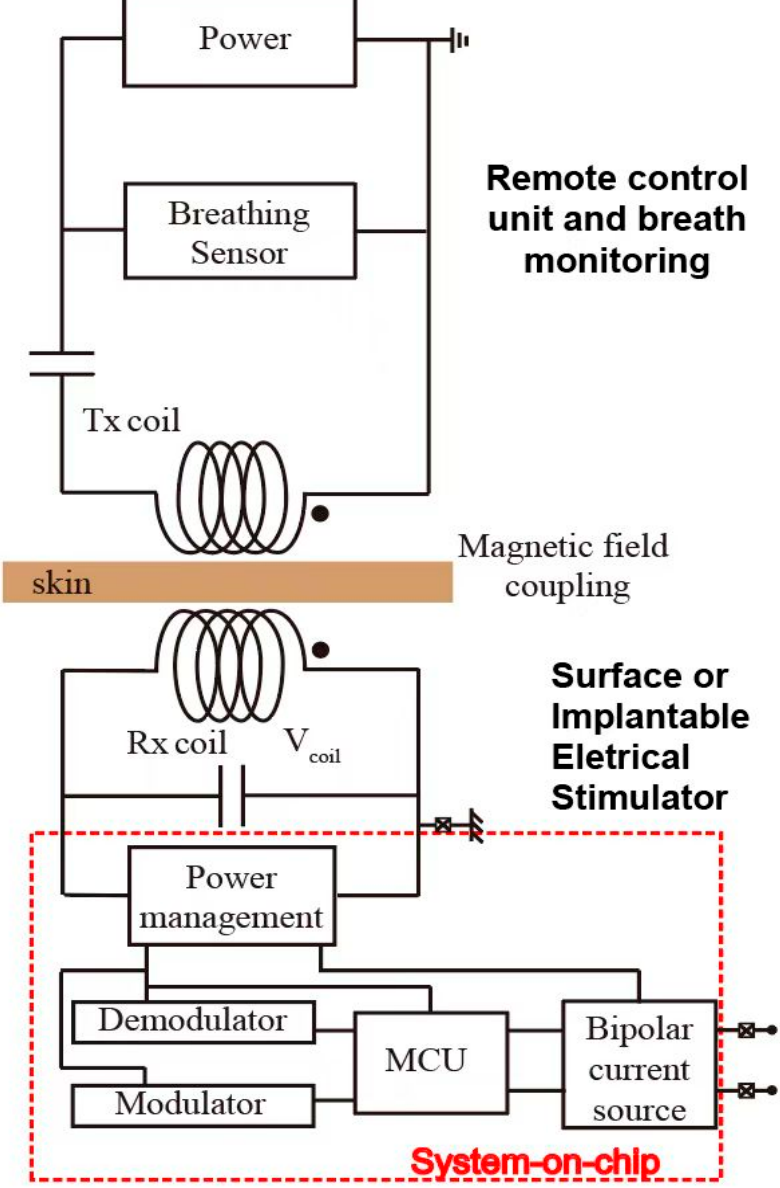
Figure 4. Breathing monitor and subsequent electrical neurostimulation interface.